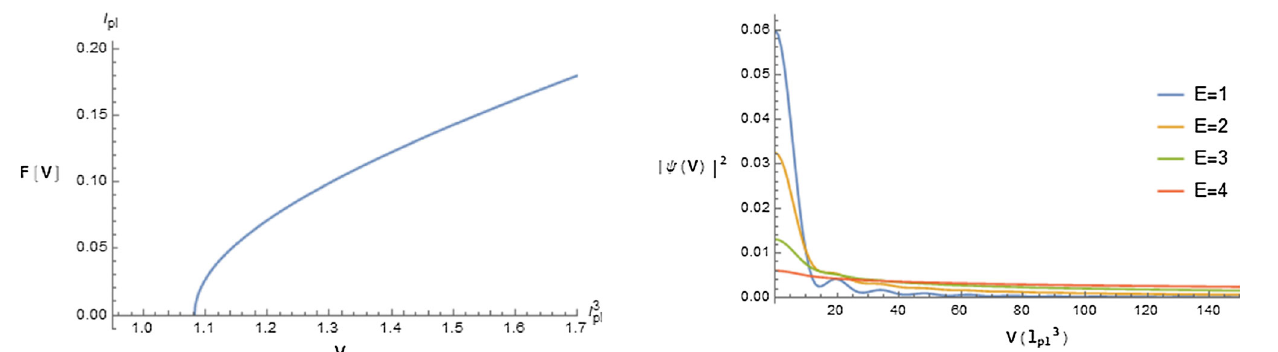
Fig. 6 The figure shows the function F ( V ) = θ( V ) a numerical integration